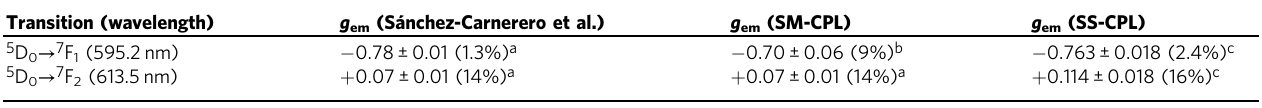
Table 2 Experimental g em values for 5.5 mM Eu{( + )-facam} 3 in anhydrous DMSO versus those obtained by reported by Sánchez-Carnerero et al. 5